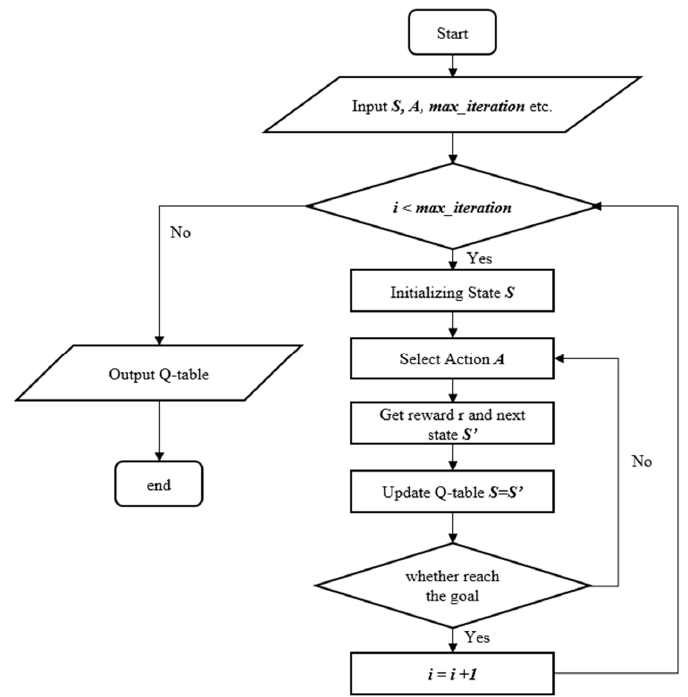
Figure 10. Flowchart of the Q-learning algorithm.